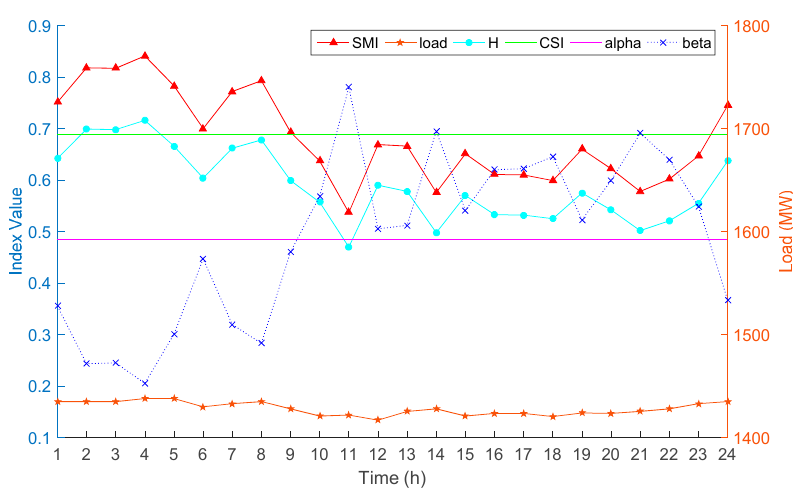
Figure 4. Index values and security level of System A.